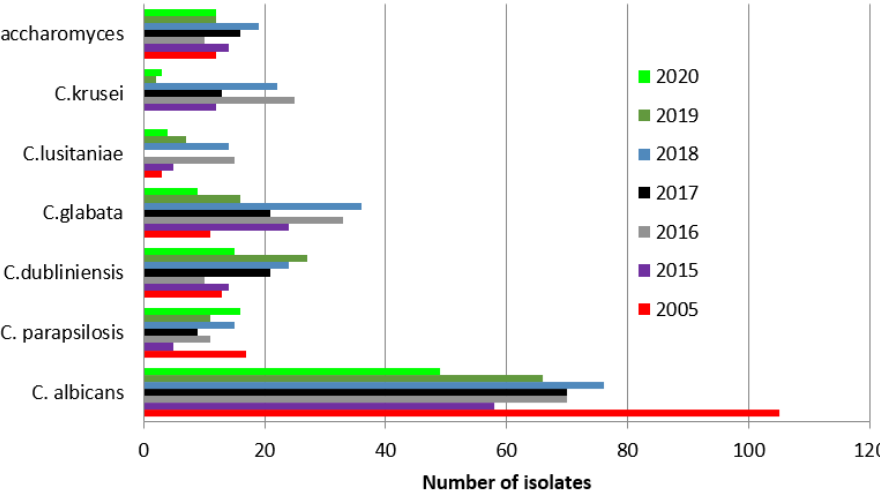
Figure 3. Most frequently isolated yeast species and Saccharomyces from clinical samples each year.